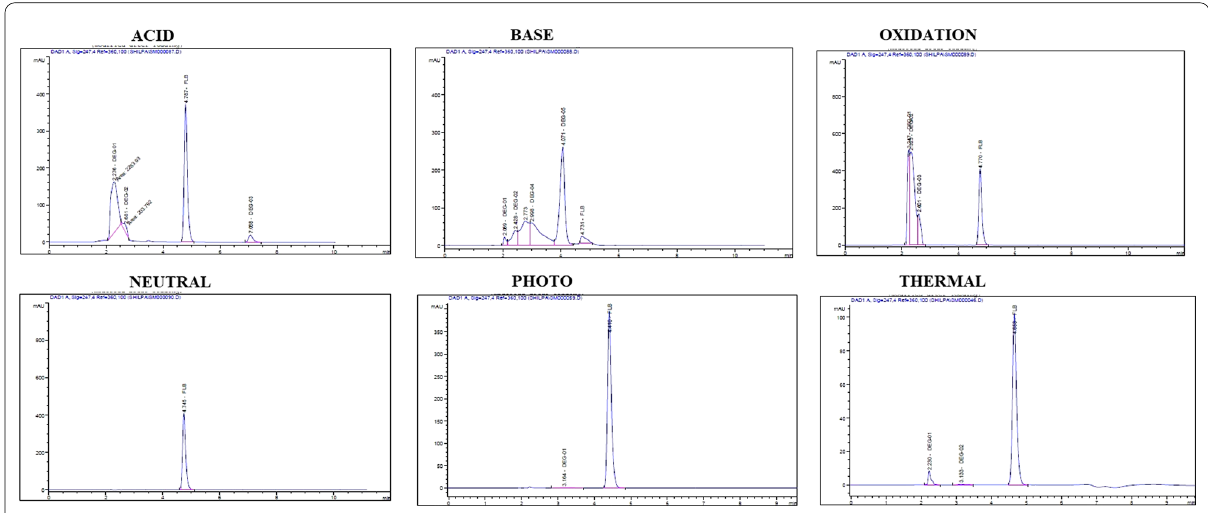
Fig. 14 Chromatograms of FBP and its degradation